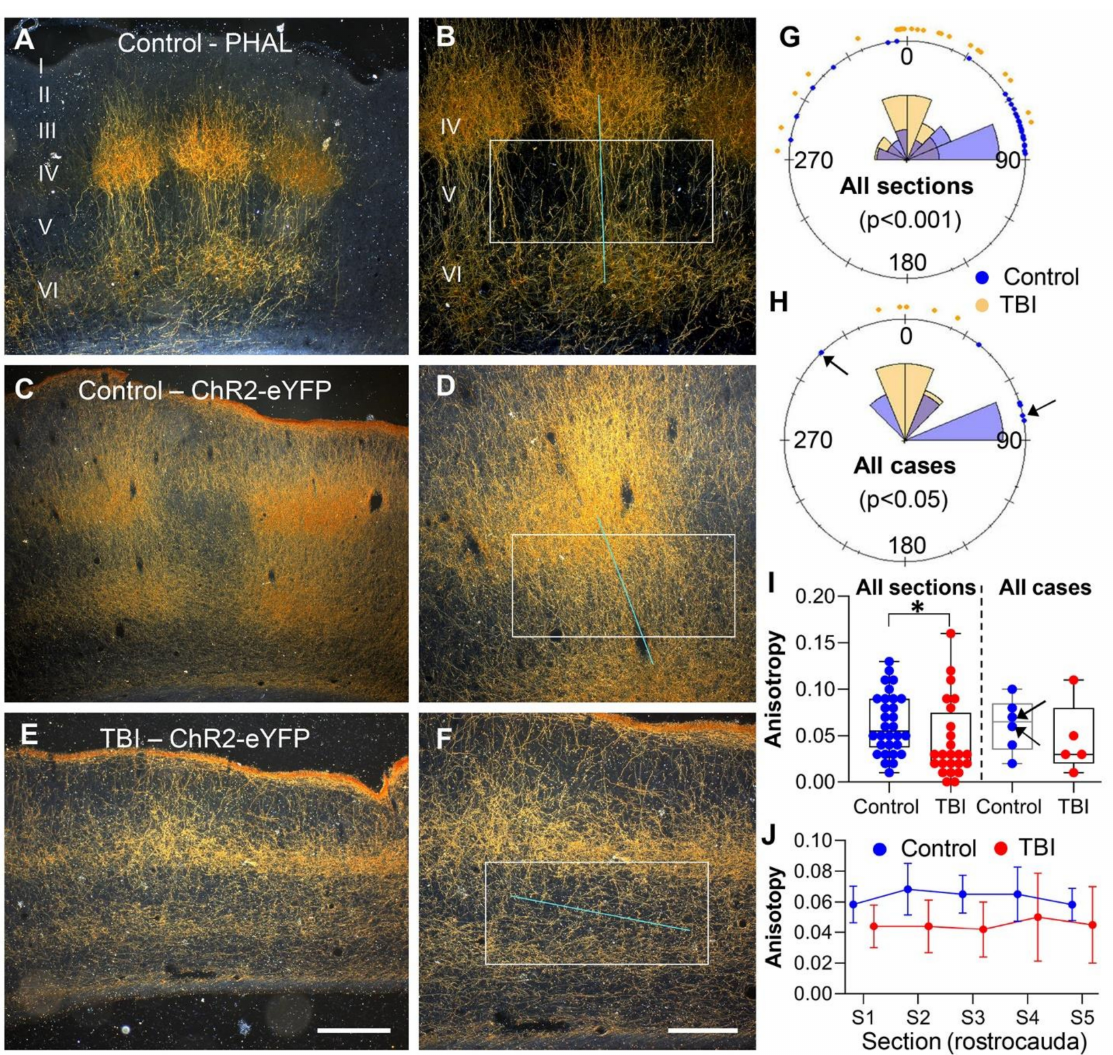
Figure 6. Orientation and anisotropy of ChR2-eYFP and PHAL-expressing fibers in layer V of the primary somatosensory (S1) cortex of a ChR2-eYFP sham-operated, PHAL-näive, and traumatic brain injury (TBI) rat. ( A ) Darkfield photomicrograph of the S1 demonstrating PHAL-ir thalamo-cortical terminals in the S1 cortex of a naïve rat. ( B ) A high-magnification photomicrograph from panel ( A ) demonstrating the average directionality of the immunopositive fibers (blue line) and anisotropy (length of the blue line) within the selected region of interest (ROI) (white selection). The spatial orientation and anisotropy of the fibers was assessed using the “FibrilTool” in ImageJ ® . The orientation is estimated based on the x-axis of the image. All the cortical images were aligned in the same way for the analysis. Note the almost 90 ◦ orientation and high anisotropy of the fibers (ordered and parallel) in layer V. ( C ) ChR2-eYFP-expressing fibers in the S1 of a sham-operated rat. ( D ) A high-magnification photomicrograph from panel ( C ). Note the perpendicular orientation of the fibers with respect to the pial surface is comparable to that in PHAL-naïve rats. ( E ) ChR2-eYFP expressing fibers in S1 of a TBI rat. Note the absence of fiber bundles seen in controls (panels A and C ). ( F ) A high magnification of panel ( E ) demonstrating a parallel orientation of the fibers in layer V within the selected ROI. ( G ) A graphical representation of the orientation in all the sections of control and TBI rats analyzed. The fibers in the controls were orientated almost perpendicular (90 ◦ ) to the pial surface in comparison to TBI rats (Watson’s two-sample test). ( H ) A graphical representation of the average orientation of fibers in each rat (Watson’s two-sample test). ( I ) A box and scatter plot demonstrating the anisotropy of the fiber in layer V of each section analyzed and the mean value in each control and TBI rat. The high anisotropy values in controls (Mann-Whitney U test) demonstrates more parallel and ordered fibers as compared to that in TBI rats. ( J ) Rostrocaudal distribution of the anisotropy in control and TBI rats. Data are presented as mean ± SEM. Arrows in H and I indicate ChR2-eYFP sham control rats. Scale bar in panels A , C, and E equals 400 µ m and in panels B , D, and F equals 200 µ m. * p <